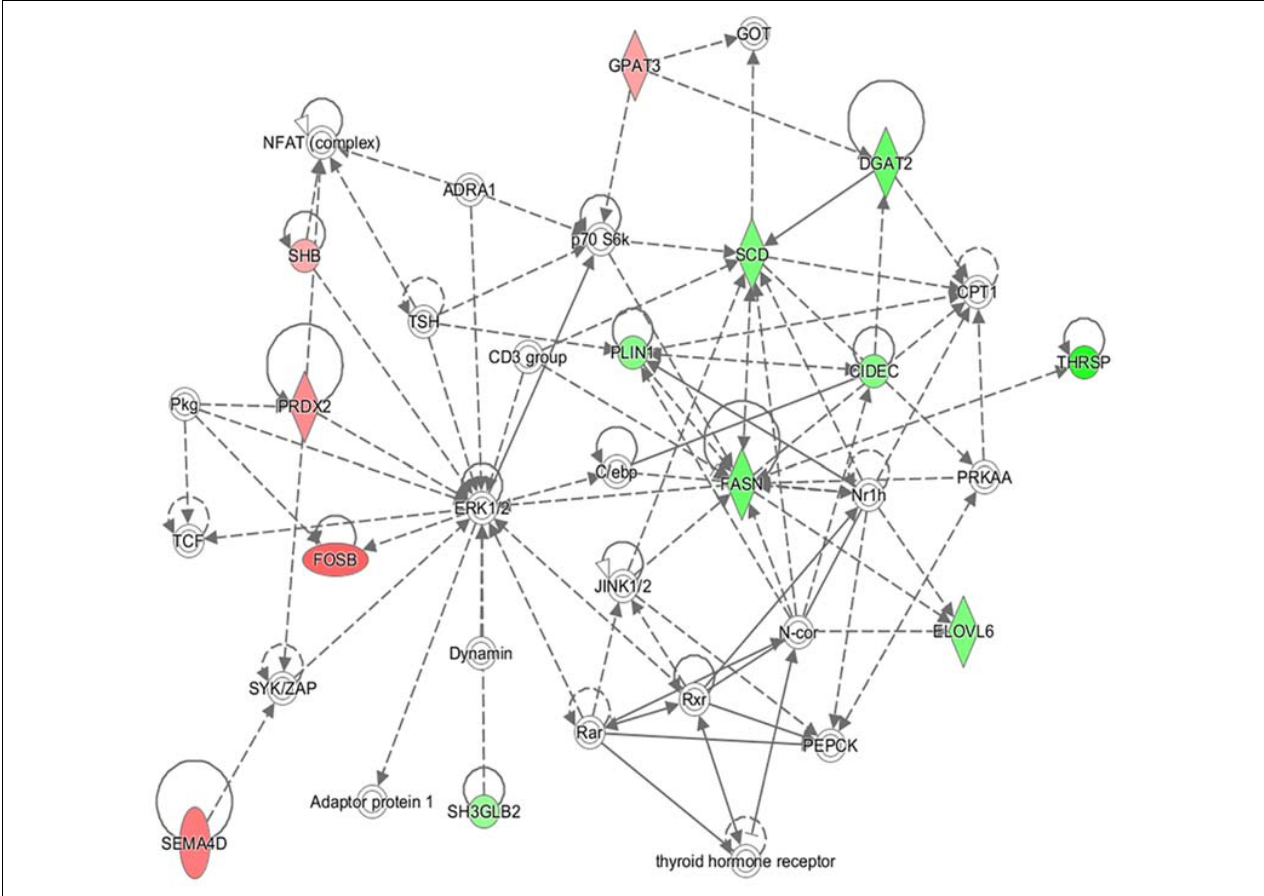
FIGURE 5 | Gene network 3: Lipid Metabolism, Small Molecule Biochemistry, and Carbohydrate Metabolism. Genes upregulated and downregulated in the H group are represented by green and red colors,